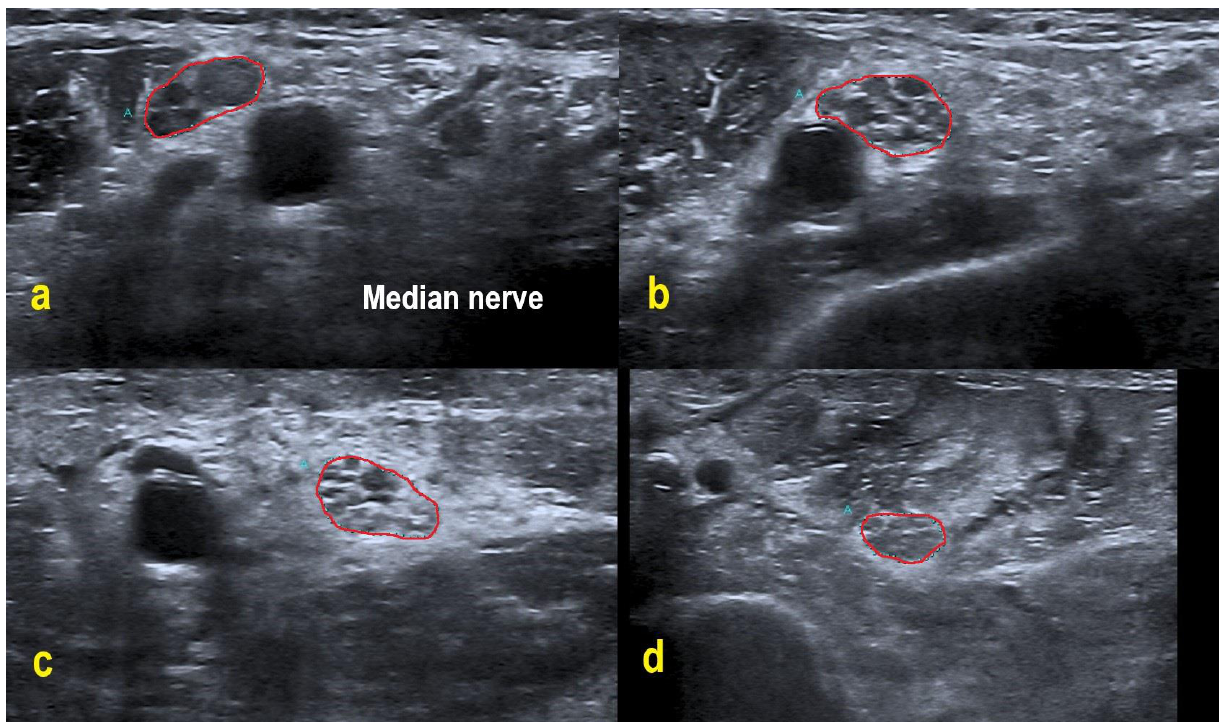
Figure 2. HRUS in POEMS syndrome patient #3. HRUS demonstrated overt homogeneous enlargement of the CSA in the right median nerve (within red border; CSA up to 2.0-fold increased). Axilla ( a ): CSA 20 mm². Upper arm ( b ): 25 mm². Midarm ( c ): 23 mm². Forearm ( d ): 15 mm². Of note, the intraneural echointensity reflects hyperechoic interfascicular tis-